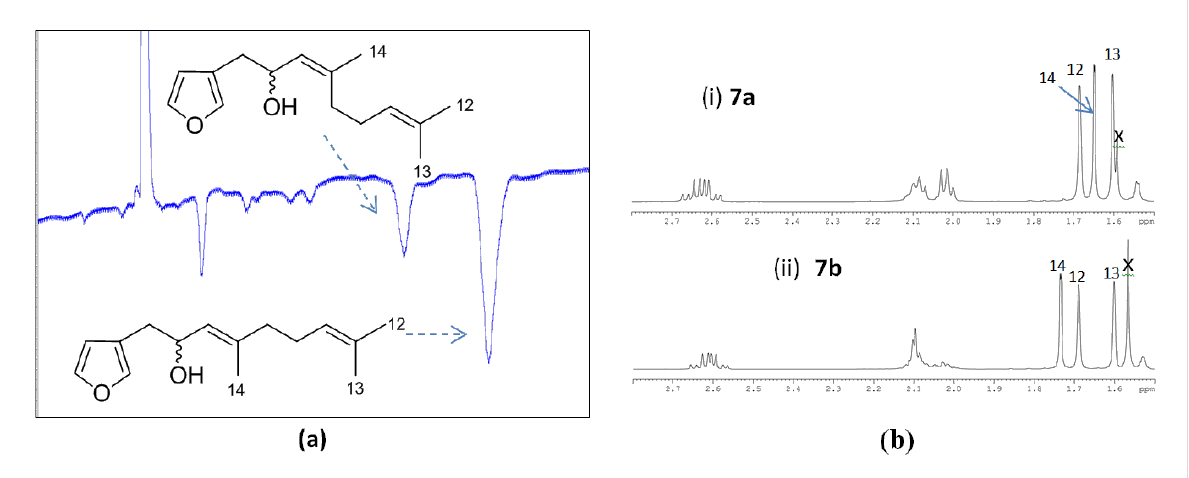
Figure 3: (a) NP HPLC trace showing separation of racemic 5-hydroxydendrolasin ( 7a/b ) using hexanes/EtOAc (90:10; flow rate 2 mL/min over 60 minutes (x axis)) and refractive index detection (y axis); (b) 1 H NMR spectroscopic comparison of (6 E )-5-hydroxydendrolasin ( 7a ) (i) and (6 Z )-5- hydroxydendrolasin ( 7b ) (ii); × = water signals.